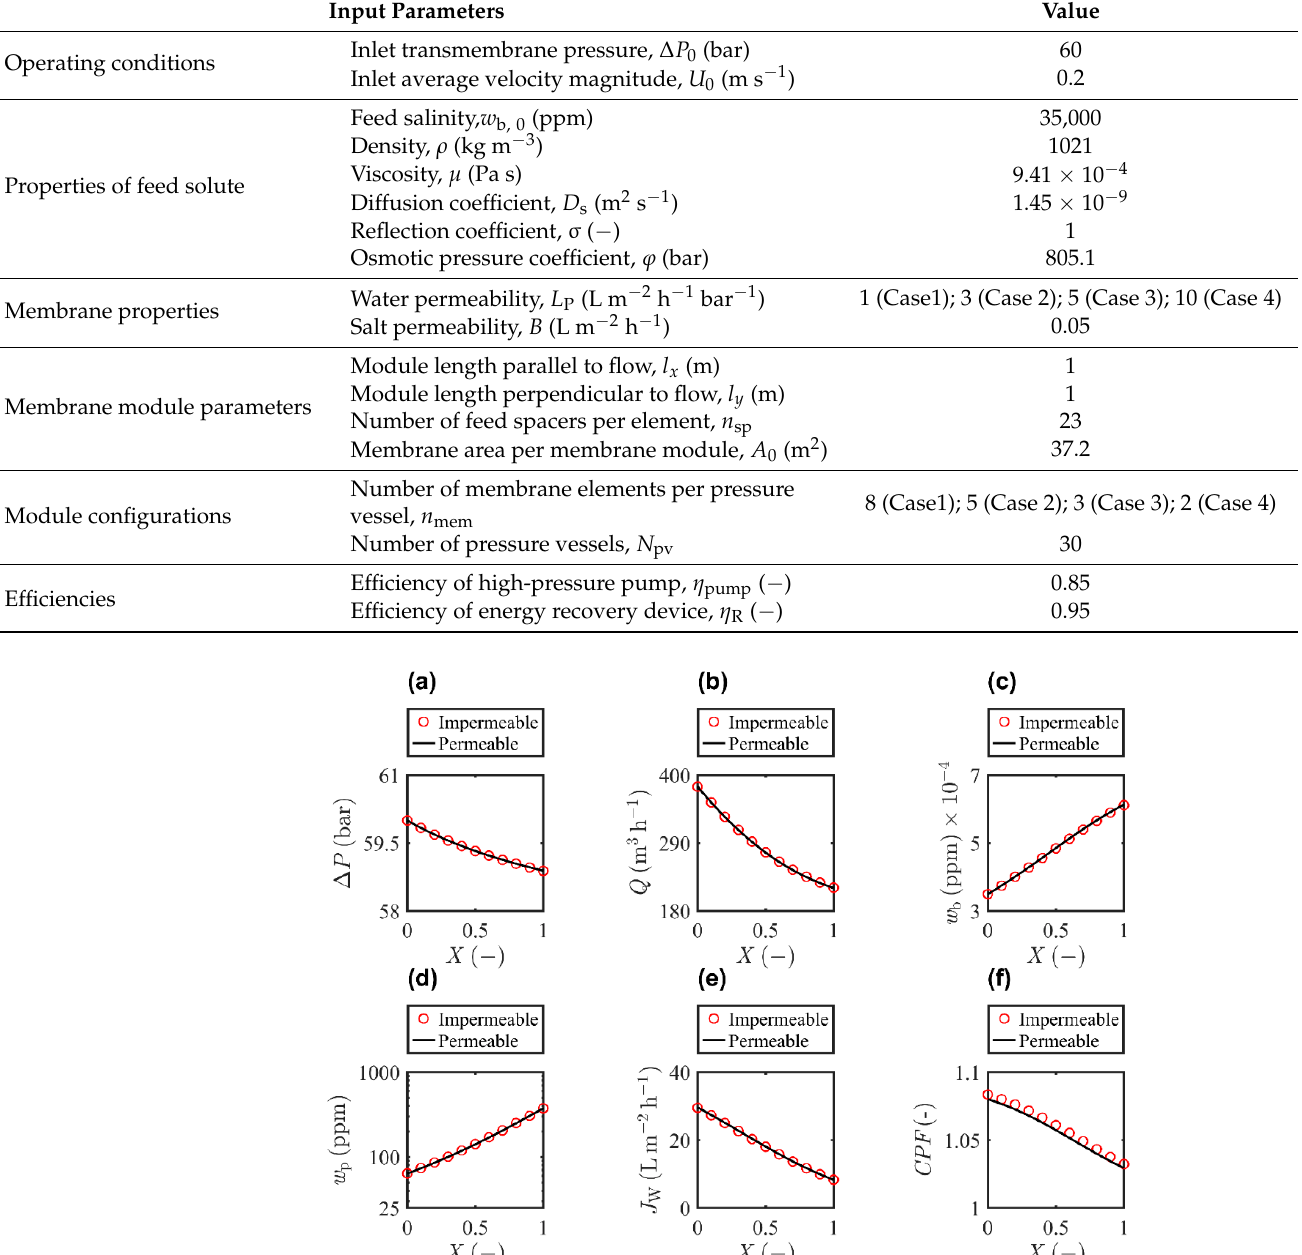
Table 2. The input parameters for SWRO systems in Cases 1–4.